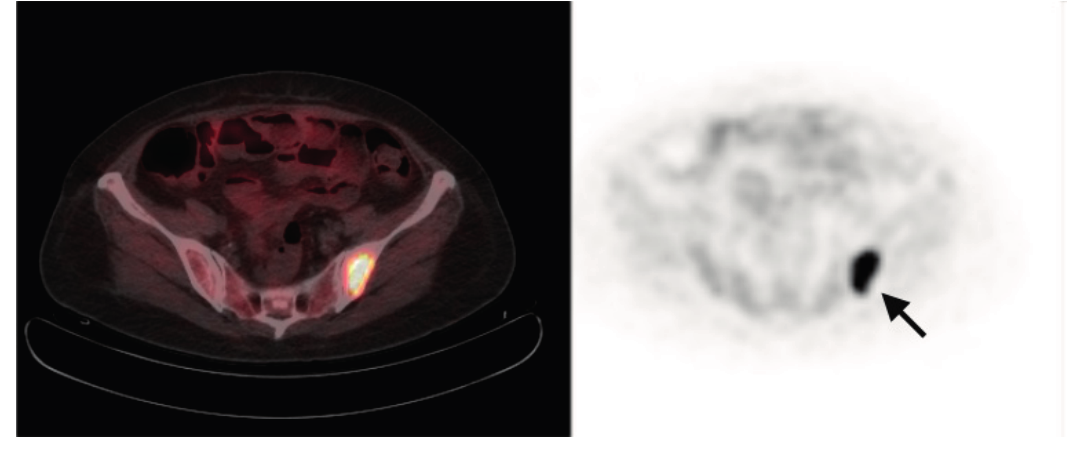
Figure 5. Metastatic HCC. Corresponding PET/CT ( left ) and PET ( right ) images show abnormal increased FCh uptake in the left posterior ilium ( arrow ) consistent with the diagnosis of skeletal